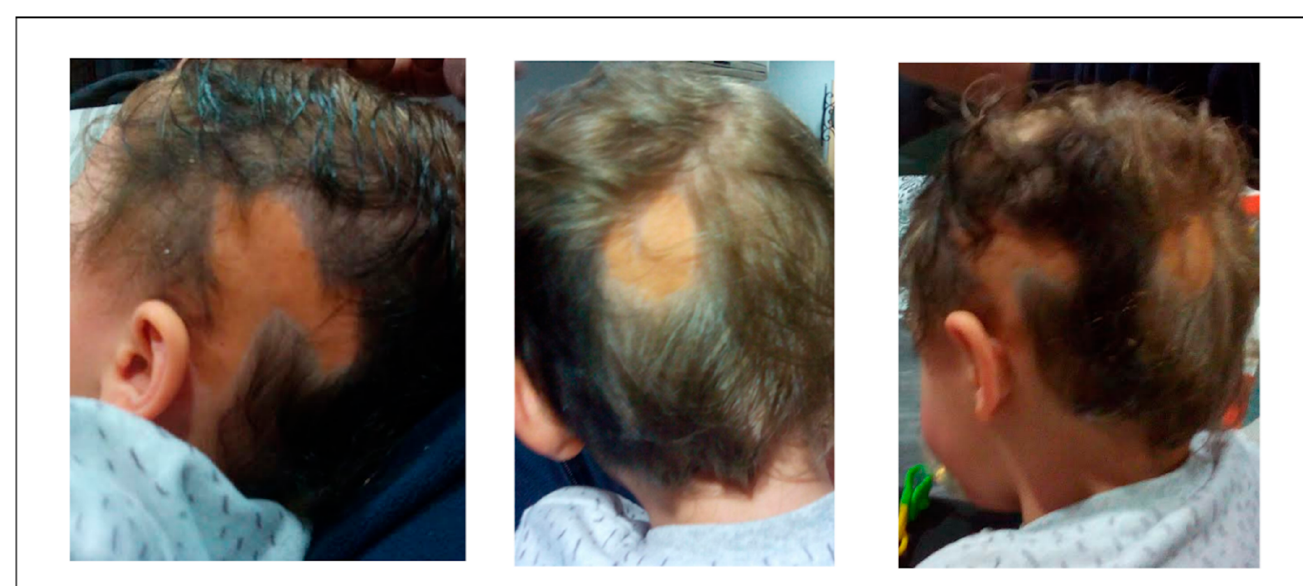
Figure 1. Linear alopecic sebaceous skin lesion in the left temporo-occipital area.